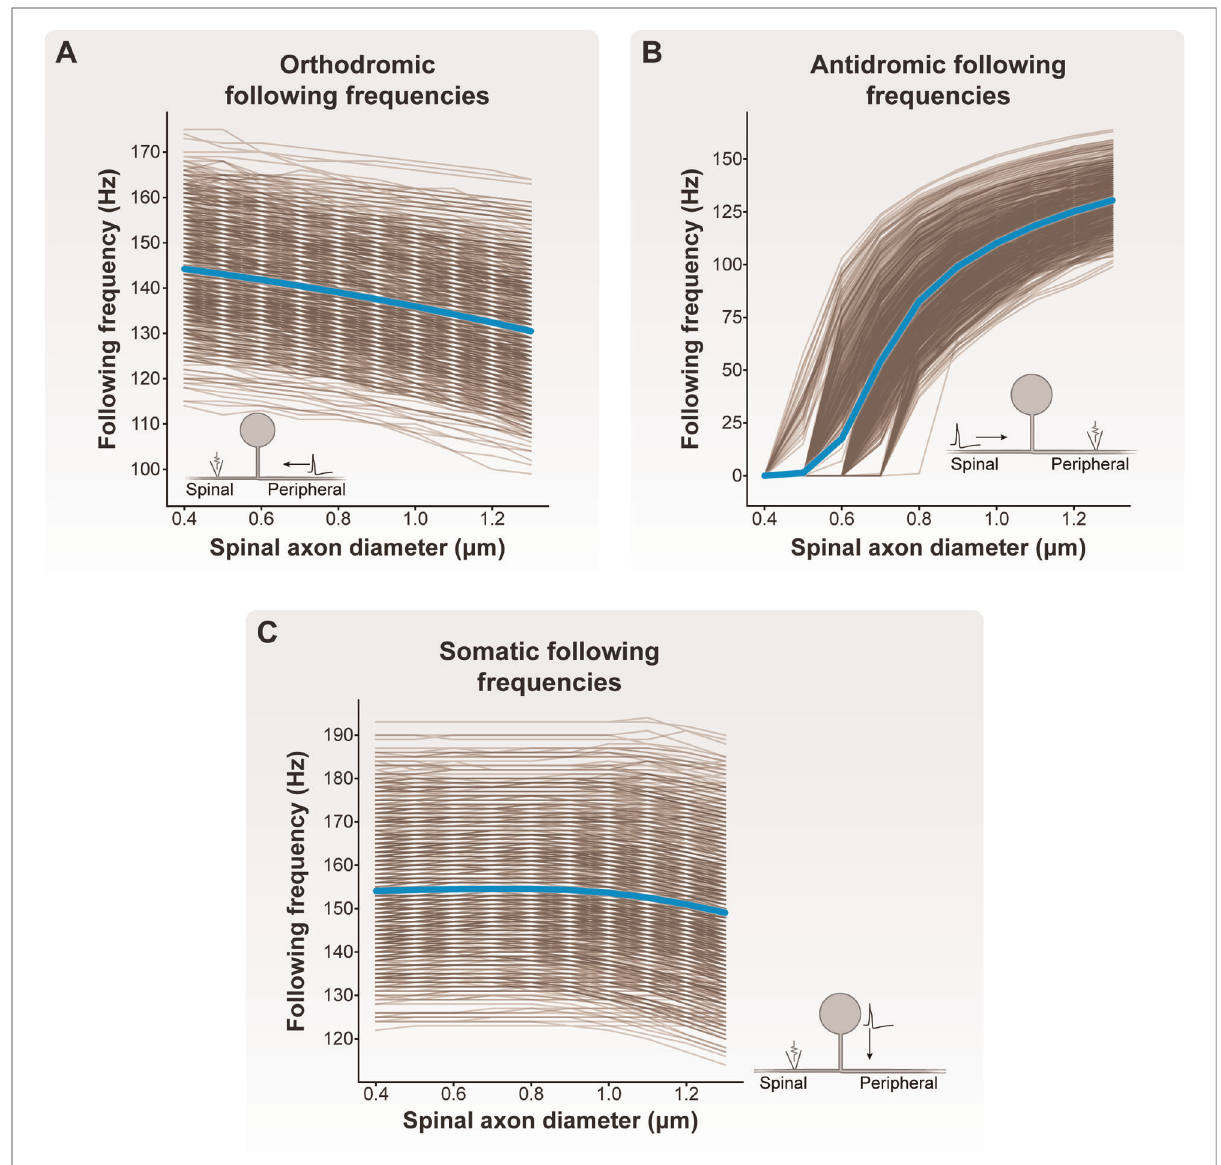
FIGURE 4 Effect of spinal axon diameter on following frequency. We varied the spinal axon diameter of each model C-neuron from 0.4 to 1.3 μ m (note: the diameters of the peripheral and stem axons were 1.3 µm). Each brown line corresponds to an individual model C-neuron, and each blue line corresponds to the model population average. Inset cartoon schematics indicate for each plot where APs were initiated, the direction of propagation, and where we recorded APs in each model C-neuron. ( A ) Increasing the spinal axon diameter reduced orthodromic (i.e., peripheral axon to spinal axon) following frequencies. ( B ) Increasing spinal axon diameter increased antidromic (i.e., spinal axon to peripheral axon) following frequencies. ( C ) Increasing spinal axon diameter decreased somatic (i.e., from soma and stem axon to spinal axon) following